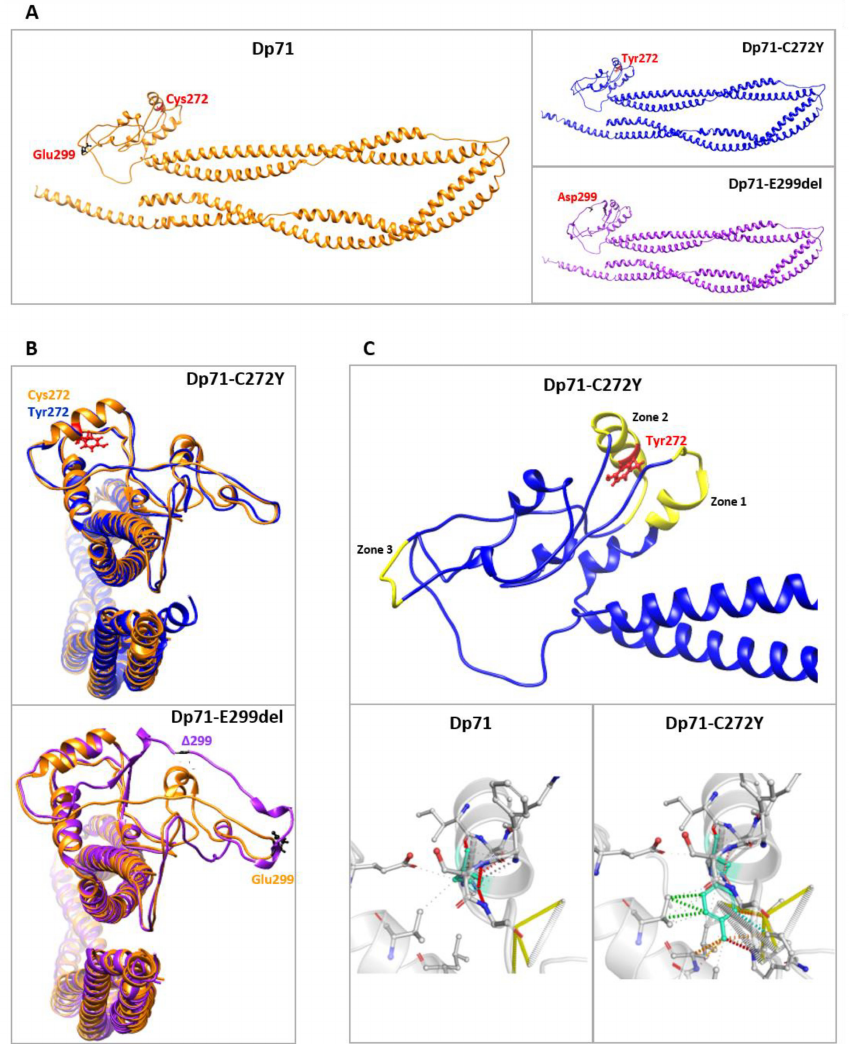
Figure 2. Structural analysis of C272Y and E299del mutations in Dp71. ( A ) Ribbon representation of the predicted Dp71 structures by I-TASSER server, illustrating the effect of C272Y and E299 mutations. ( B ) Superimposition of Dp71 (orange) with Dp71-C272Y (blue; upper panel) and Dp71 (orange) with Dp71-E299del (purple; bottom panel), highlighting the structural differences between Dp71 and its mutant variants. Protein models were visualized using Chimera v 1.16 (www.cgl.ucsf.edu/chimera/; accessed on 10 and 15 February 2022). ( C ) Upper panel: Ribbon representation of the effect of C272Y mutation on Dp71 structure. Amino acids are colored according to the vibrational entropy change upon mutation; yellow represents a rigidification of the structure in Dp72-C272Y mainly at positions 230 to 241 (zone 1), 265 to 280 (zone 2) and 295 to 300 (zone 3). Lower panels: Cys and Tyr amino acid residues at position 272 of wt and mutant Dp71, respectively, are colored in light green. In Dp71, hydrogen bonds are shown in red, while substitution by tyrosine in the C272 mutant causes a change in the surrounding interatomic interactions characterized by hydrophobic contacts (green) and weak hydrogen bonds (orange). Analyses were generated using the server